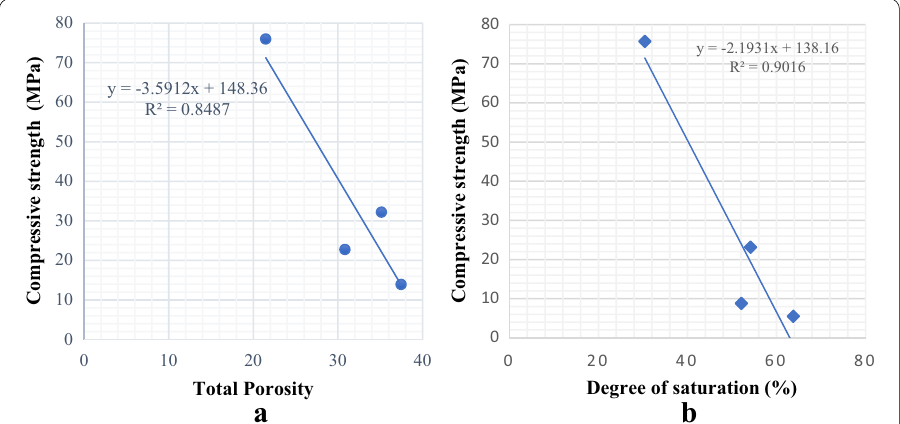
Fig. 8 a Influence of porosity on compressive strength of dry specimens. b Influence of degree of saturation on of the compressive strength of water immersed specimens